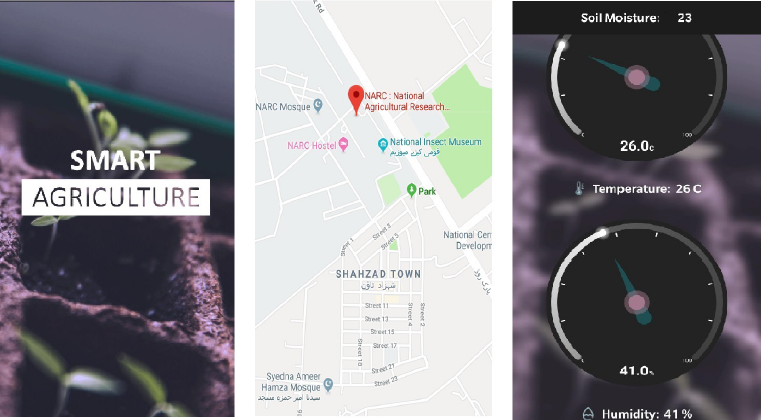
Figure 3. User interface of the mobile